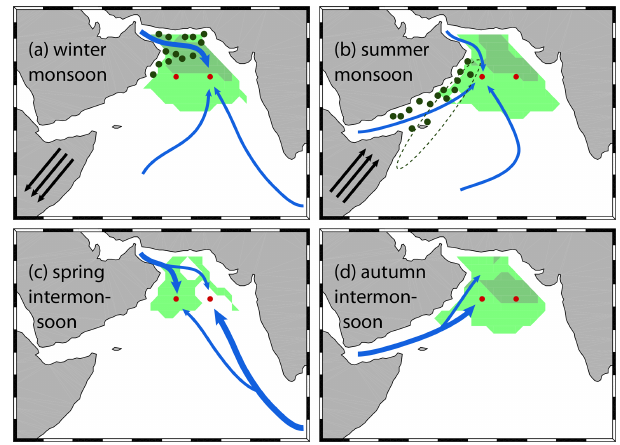
Figure 11. Schematic of the main advective pathways of the wa- ter masses for the (a) winter monsoon, (b) summer monsoon, (c) spring intermonsoon, and (d) autumn intermonsoon seasons. See also Fig. 1. The dark green dots indicate regions of strong net primary production as shown in Acharya and Panigrahi (2016). The dotted line in (b) marks the main upwelling region along the coast during the summer monsoon. The wind direction during mon- soon phases is indicated by the black arrows (a, b) . The green patches sketch the location of the Arabian Sea OMZ as in WOA13 data: light green marks the area where the 10µmolkg − 1 layer is thicker than 650m, and the darker green marks the area where the 10µmolkg − 1 layer is thicker than